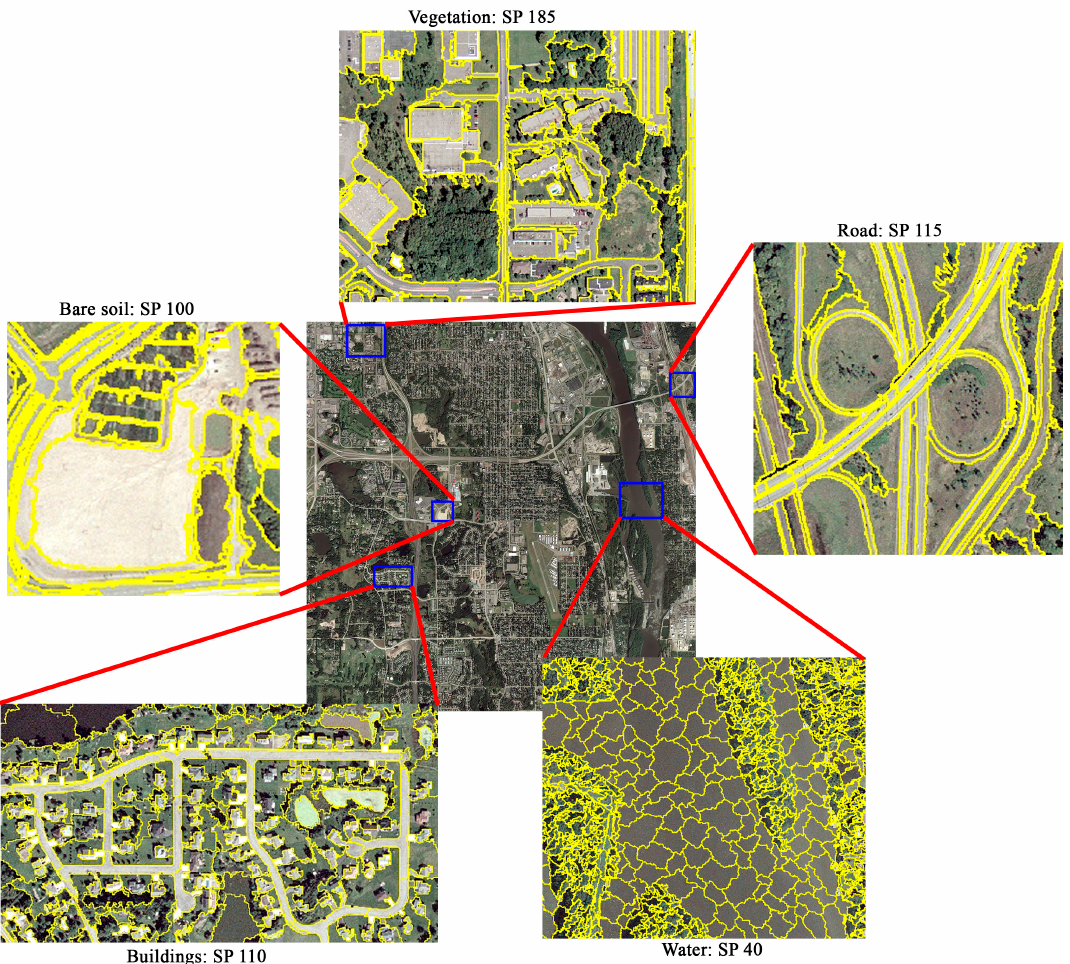
Figure 6. Segmentation results of the building, vegetation, road, bare soil, and water classes in the 75-cm test image.